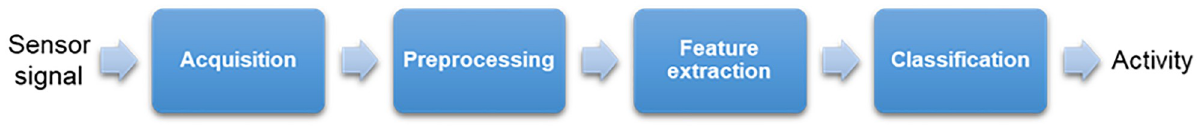
Fig 5. Workflow of activity recognition based on machine